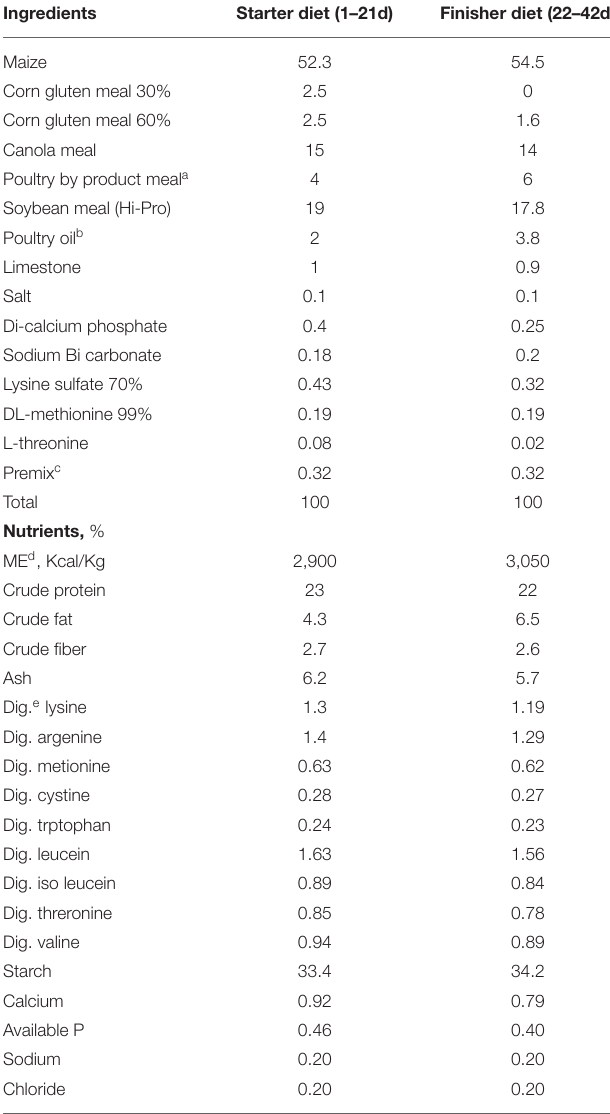
TABLE 2 | Diet formulation and chemical analysis. Ingredients